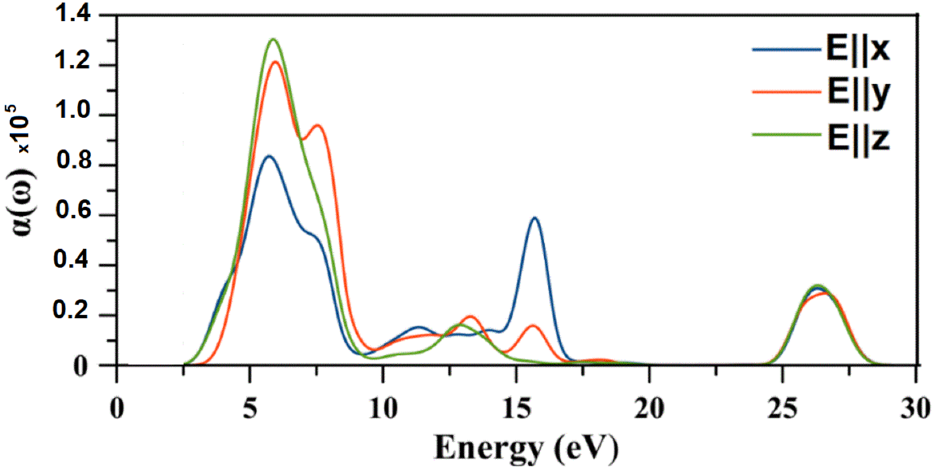
Figure 15. Variation of the absorption coefficient as a function of the energy of the (C 2 H 7 N 4 O) 2 BiCl 5 compound.